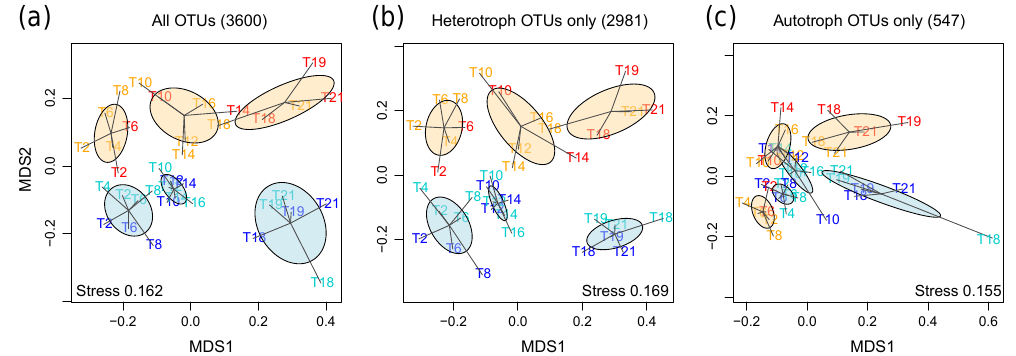
Figure 5. NMDS ordination of all samples using Bray–Curtis distances based on the relative abundances of (a) all OTUs, (b) only non- cyanobacterial OTUs (“heterotrophic bacteria”), or (c) only OTUs classified as photosynthetic cyanobacteria. The samples are color-coded as follows: orange for the M1 surface, red for M1 12m, light blue for the Nouméa lagoon surface, and blue for Nouméa lagoon 12m. Ellipses are color-coded in a similar way to distinguish M1 sample clusters and Nouméa lagoon sample clusters. Ellipses denote a confidence interval of 0.95 around the weighted average of each cluster. Thus, clusters can be considered significantly different with α = 0.05, if ellipses do not